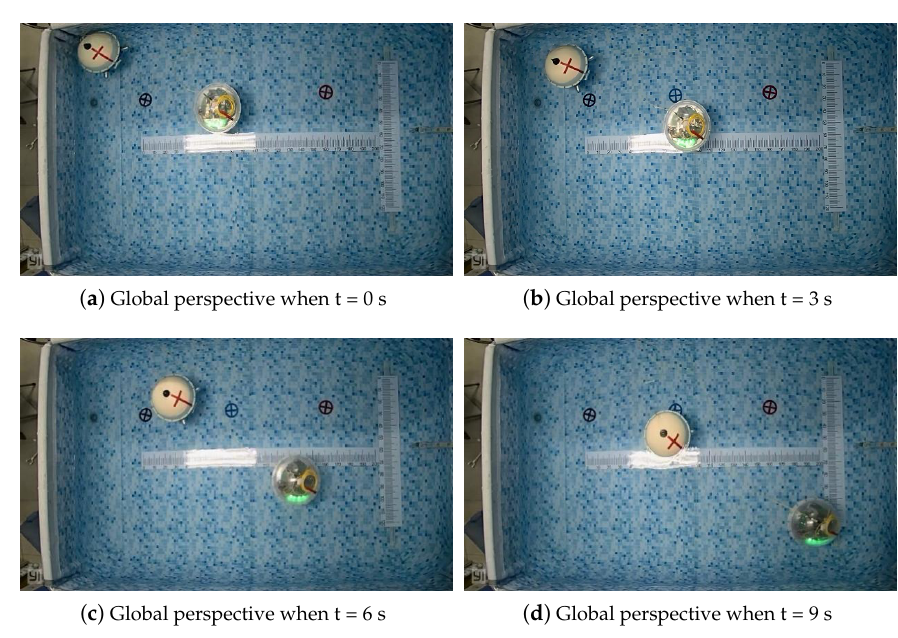
Figure 15. Images of global perspective and follower perspective of two robots dynamic straight-line formation experiment.